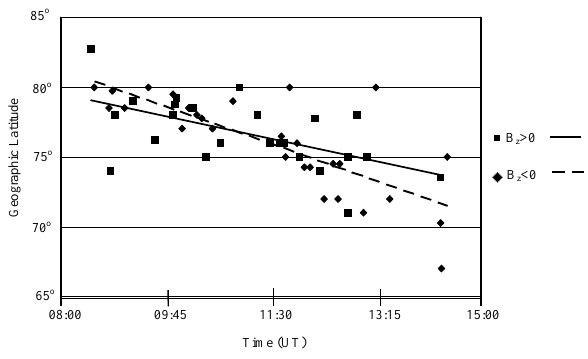
Fig. 8. Scatter plot of the latitude of the trough minimum obtained from tomography images between 08:30 UT and 14:30 UT, cate- gorised according to IMF B z positive (squares and solid line) and B z negative (diamonds and dashed